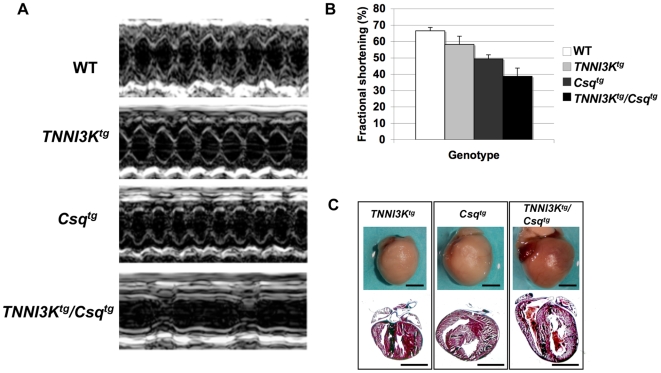
TNNI3K expression leads to severely impaired cardiac function in the Csqtg transgenic model of cardiomyopathy.M-mode echocardiograms were performed on 14-day-old mice from a cross between TNNI3Ktg and Csqtg transgenic animals. (A) Representative echocardiograms showed that the double positive transgenic mice display severe left ventricle systolic dysfunction and chamber dilation (in the bottom). (B) Analysis of the echocardiogram data shows that fractional shortening (FS), which indicates cardiac function, is decreased in double positive transgenic mice compared to other littermates. Data is represented by mean±error of the mean (SEM) for wild type, TNNI3Ktg, Csqtg, and TNNI3Ktg/Csqtg. The number of animals in each group is as follows: wild type, n = 12; TNNI3Ktg, n = 8; Csqtg, n = 14; and TNNI3Ktg/Csqtg, n = 6. (C) Whole hearts and representative histological sections are shown stained with Masson Trichome. Consistent with echocardiographic data, the TNNI3Ktg/Csqtgmouse hearts show severe dilation in comparion to TNNI3Ktg and Csqtg single transgenic animals.